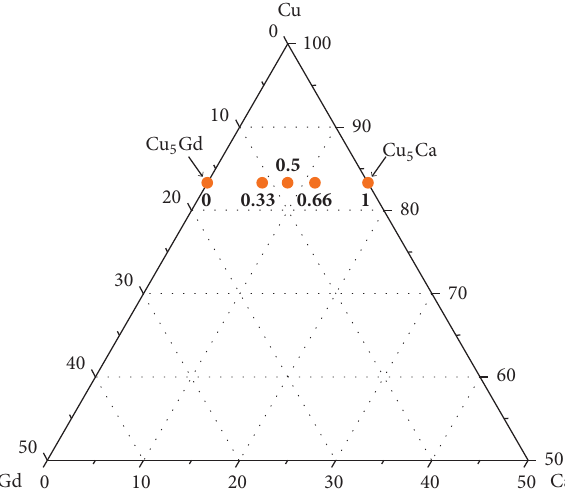
Figure 1: The Cu-rich half of the Cu-Gd-Ca ternary concentration chart with the studied Cu 5 Gd 1−𝑥 Ca 𝑥 compositions marked by dots, near to which 𝑥 values are